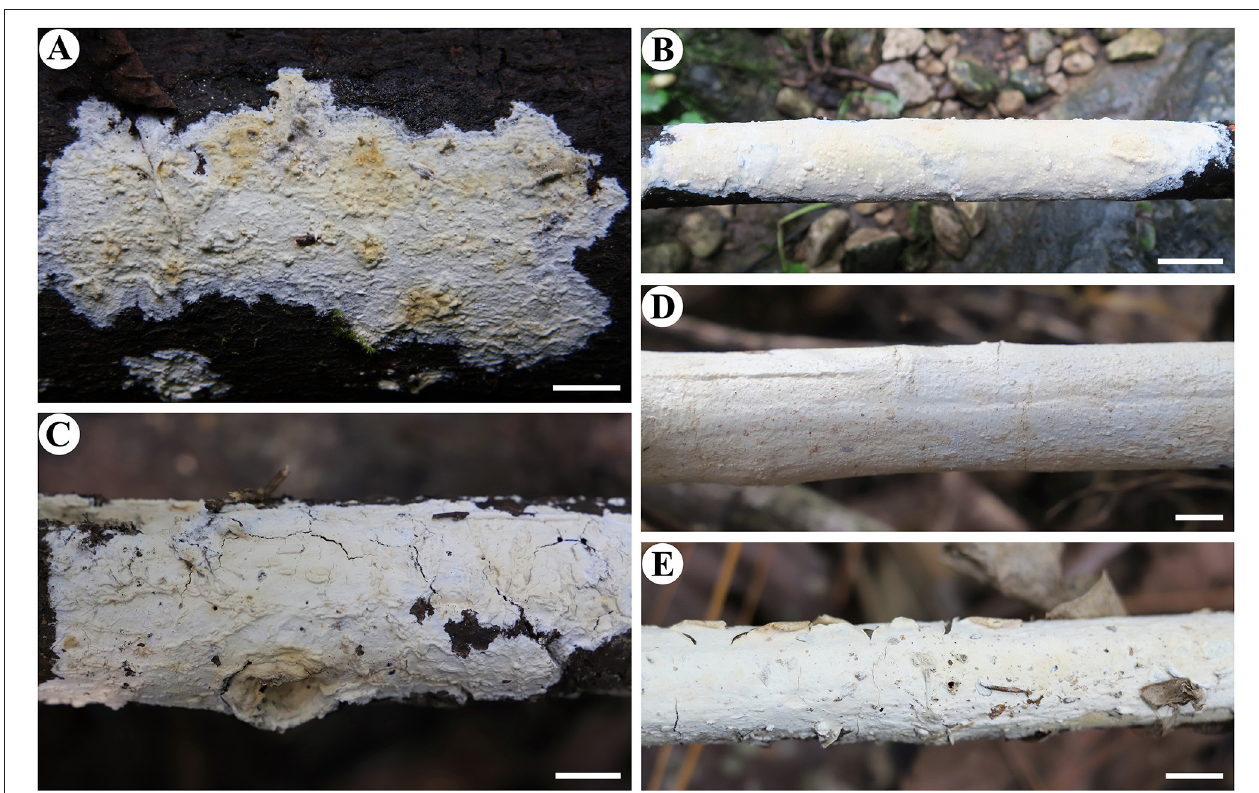
FIGURE 8 | Basidiomata of Irpex alboflavescens (scale bars: A–E = 1cm). (A) He 2278; (B) He 4719; (C) He 5783; (D) He 6355; (E) He 5732.